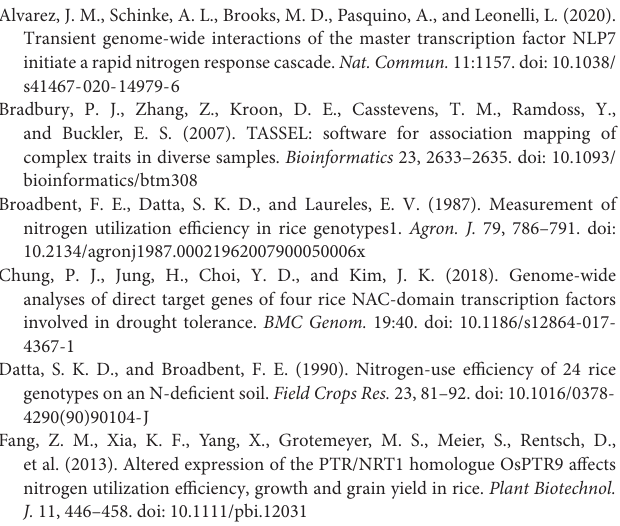
Supplementary Table 8 | Yield-related characteristics of WT and transgenic rice under DN and SN conditions. Values are means ± SD ( n = 5), ∗ P < 0.05, ∗∗ P < 0.01 ( t